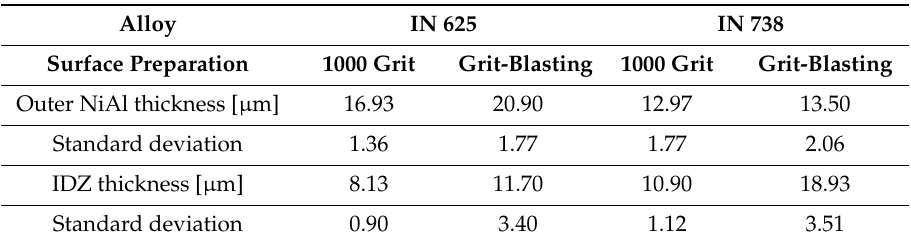
Table 2. Measurements of the thickness of the outer NiAl layer and interdi ff usion zone (IDZ) formed on ground and grit-blasted IN 625 and IN